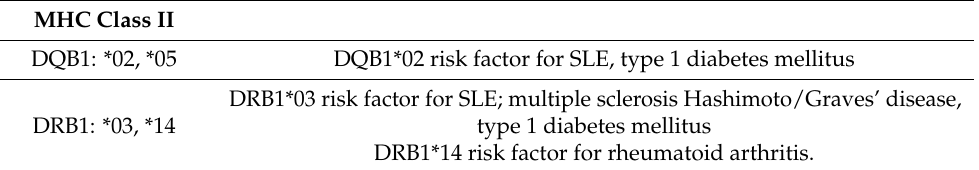
Table 1. The genetic testing of our patient revealed multiple high-risk gene patterns for autoimmune diseases [4].